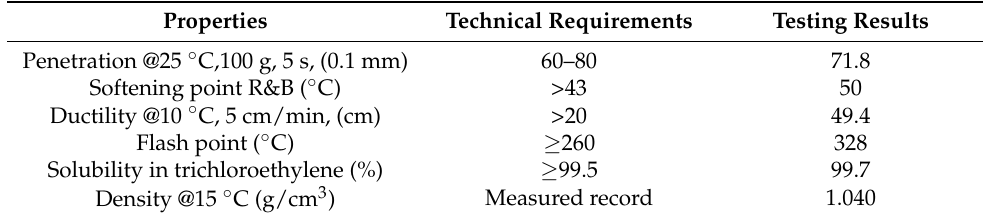
Table 1. Properties of the 70# petroleum bitumen.